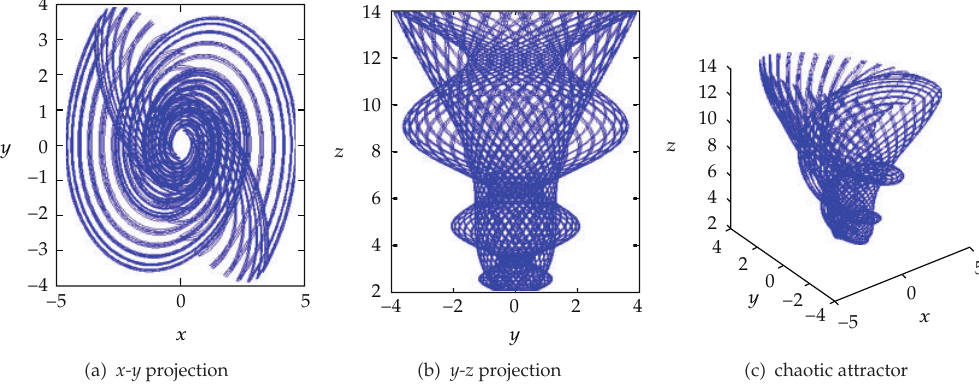
Figure 4: Chaotic attractor generated by z 1 (cid:7) 2, z 2 (cid:7)